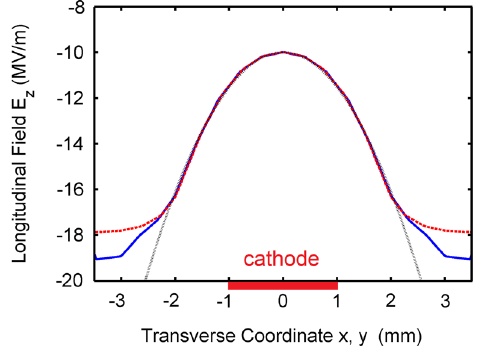
FIG. 6. The electric field profiles on the cathode surface along (red) and across (blue) the inner conductor. The dotted black curve represents the analytical approximation